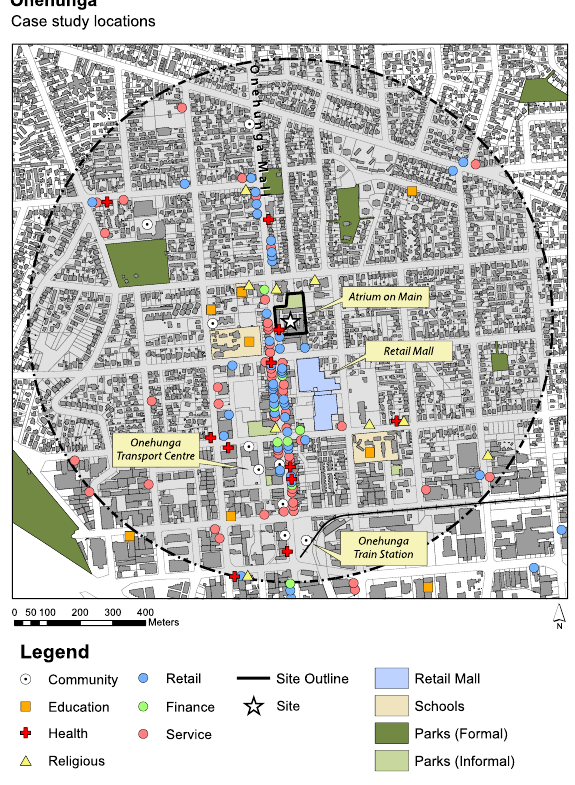
Figure 4. Auckland urban region showing the CBD (blue), and in red, Albany to the North and Onehunga to the south.